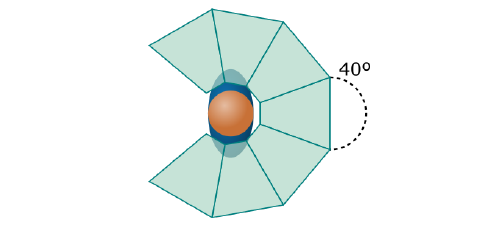
Figure 2. Panoramic view example. In this example, a panoramic field of view of 280 ◦ is composed by 7 different projections of 40 ◦ .